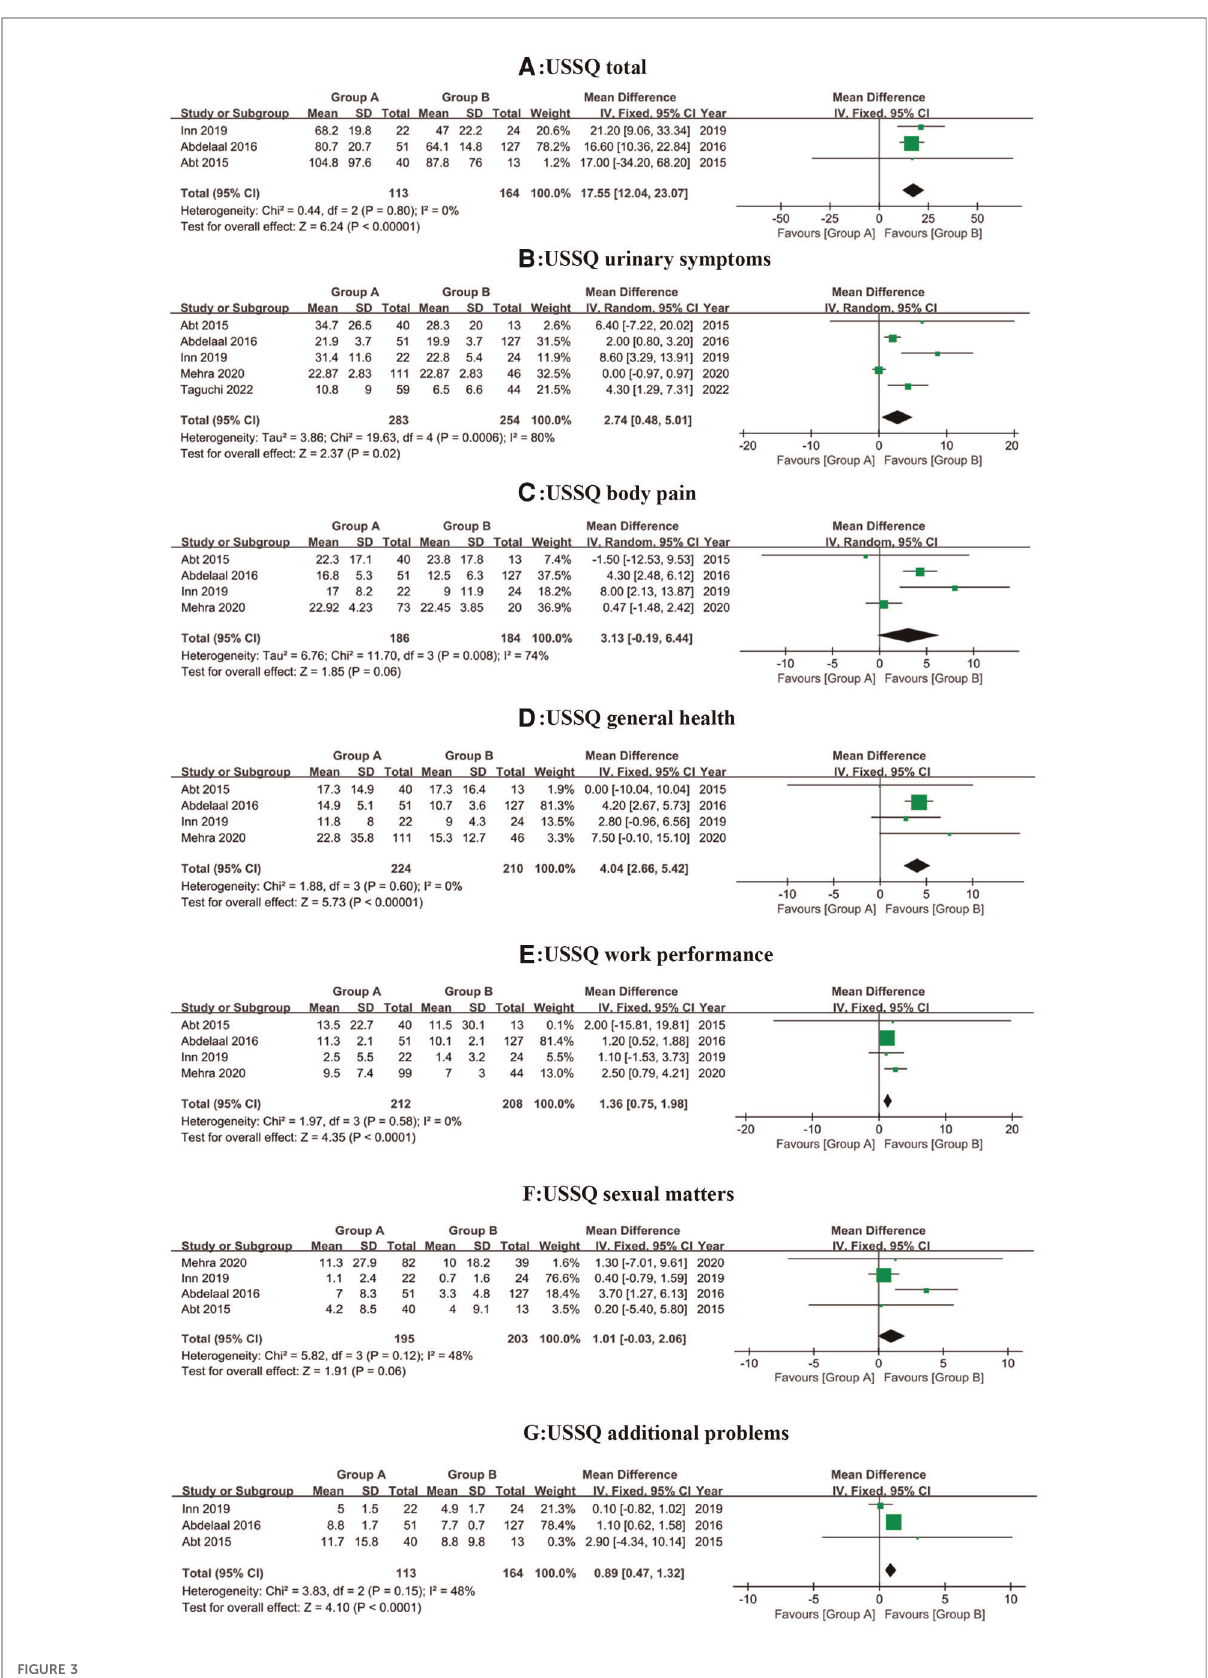
FIGURE 3 Forest plot depicting changes in USSQ total score and